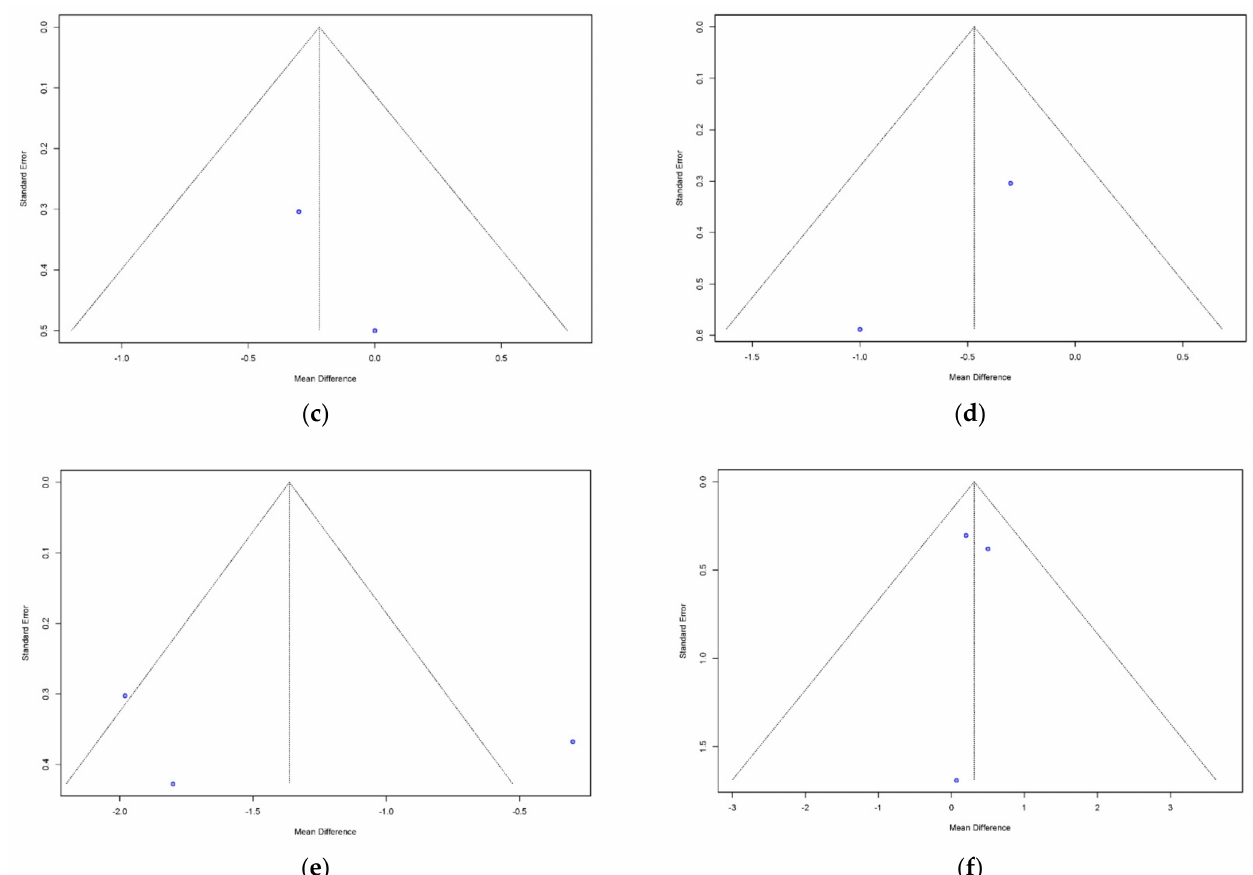
Figure 6. Funnel plots to detect publication bias of mean difference between 3D-TEE and MDCT. Bias and p values of asymmetry derived from Egger’s test are shown for annular sizing parameters. ( a ) Aortic annular area (bias = 1.72, p = 0.56); ( b ) Aortic annular perimeter (bias = 0.45, p = 0.84); ( c ) Annular area-derived diameter (Unable to test); ( d ) Annular perimeter-derived diameter (Unable to test); ( e ) Annular maximum diameter (bias = 4.62, p = 0.80); ( f ) Annular minimum diameter (bias = − 0.03, p = 0.98). 3D-TEE = Three-dimensional transesophageal echocardiography, MDCT = Multidetector computed tomography.